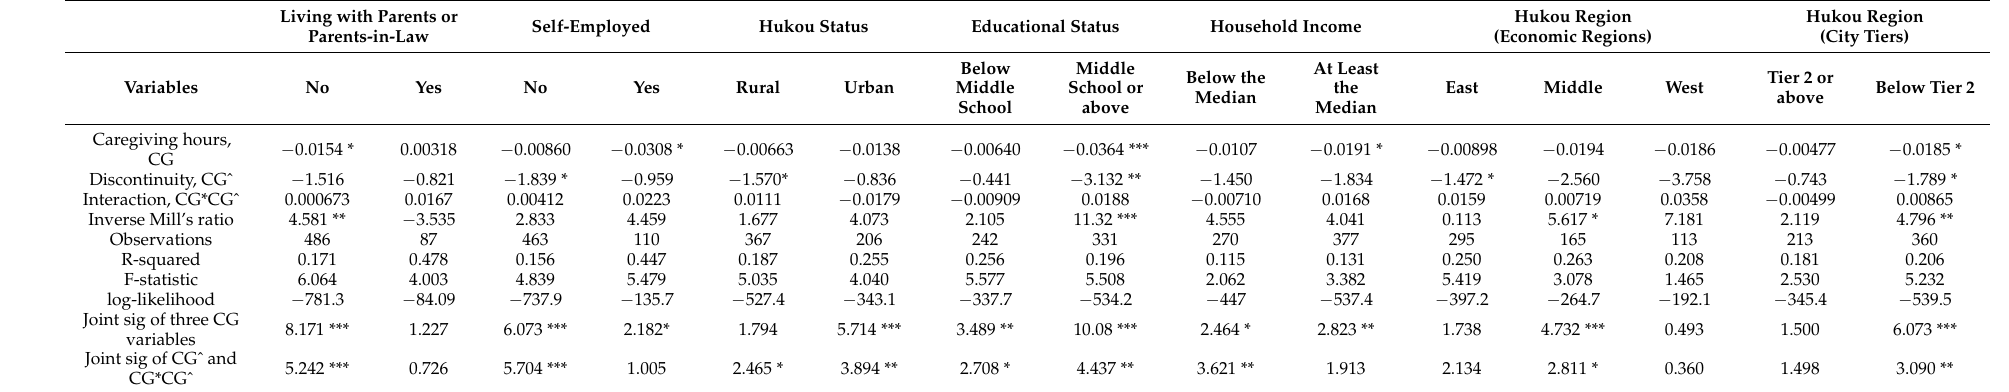
Table A5. Subgroup analysis on women using the Heckman procedure and assuming a weekly caregiving threshold of 63 h.